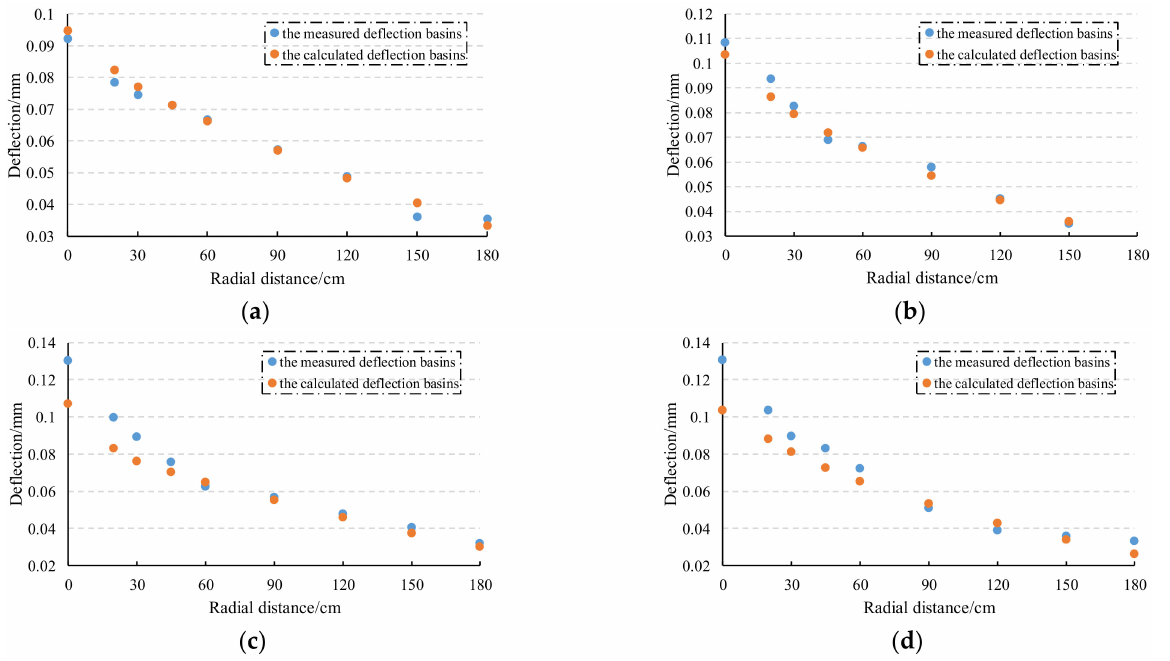
Figure 4. Comparison of deflection basins at different temperatures: ( a ) 16.1 ◦ C; ( b ) 25.1 ◦ C; ( c ) 35.2 ◦ C; ( d ) 41.6 ◦ C.